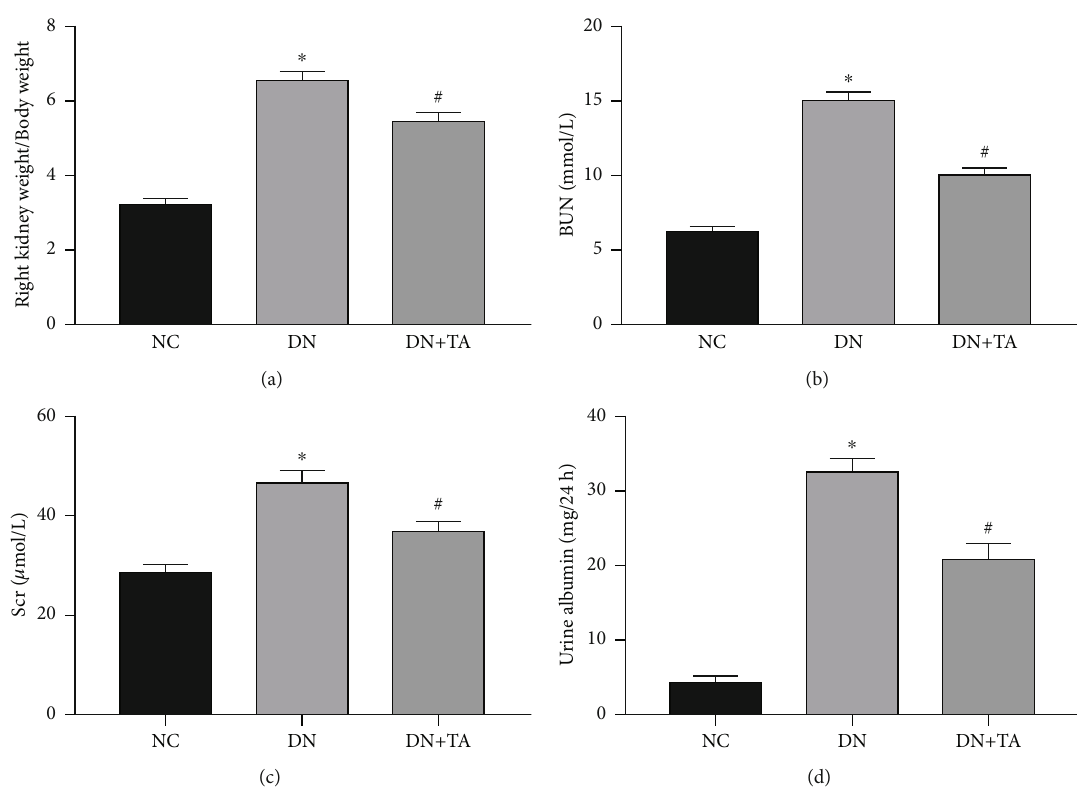
Figure 1: TA administration signi fi cantly ameliorated renal function in DN. Increased ratios of right kidney weight/body weight (a), BUN (b), Scr (c), and urine albumin (d) inDN mice were revised byTA. Data were expressedas mean ± SD ( n = 10 ). ∗ P < 0 : 05 versusNC group; # P < 0 : 05 versus DN